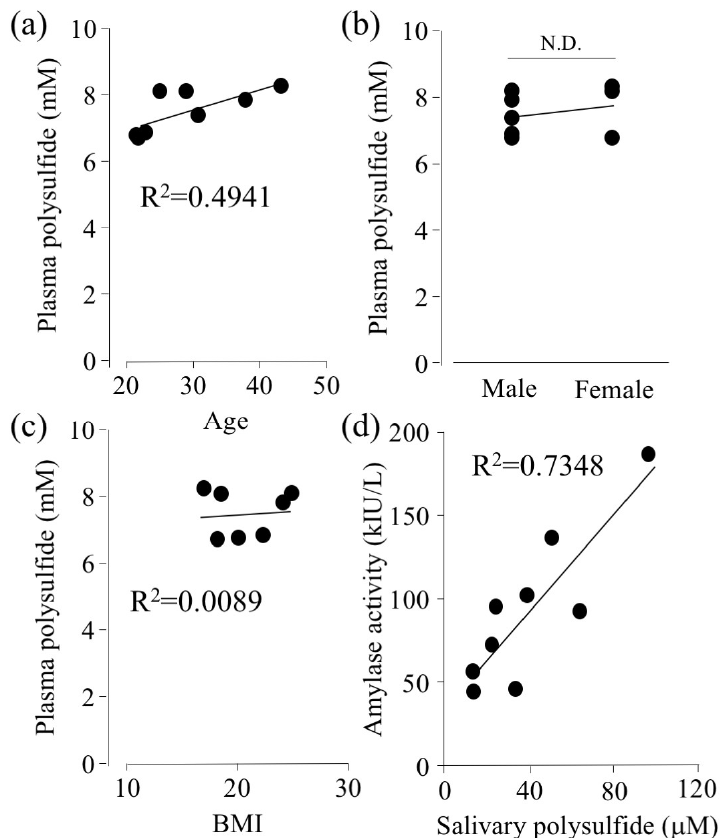
Figure 2. Comparison of the plasma polysulfide level to biological parameters, ( a ) age, ( b ) sex, and ( c ) BMI. ( d ) Investigation of interrelation between salivary polysulfide and amylase activity. Calculated polysulfide level was analyzed by EMSP. Amylase activity was measured by an amylase monitor.